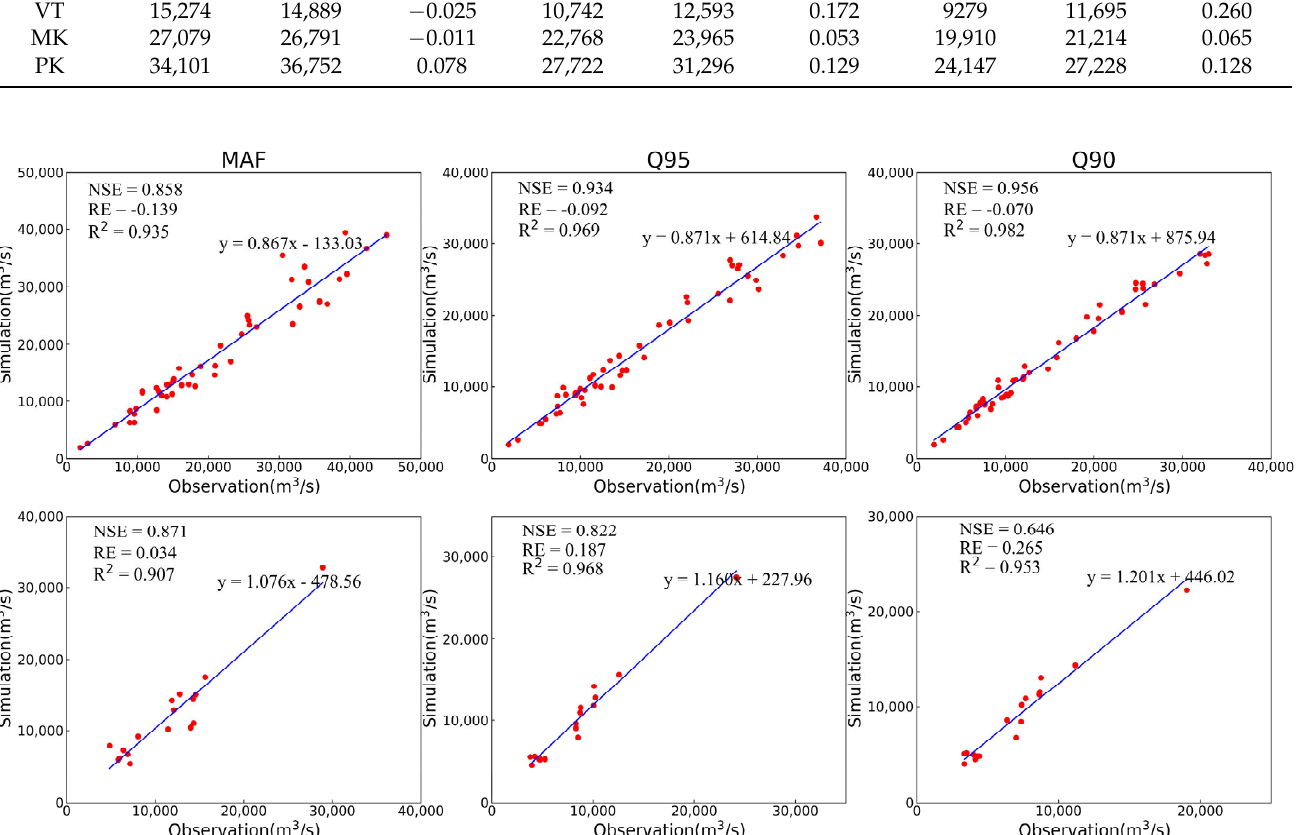
Table 4. Flood indicators performance of HPD model for human impact period (2008–2015).